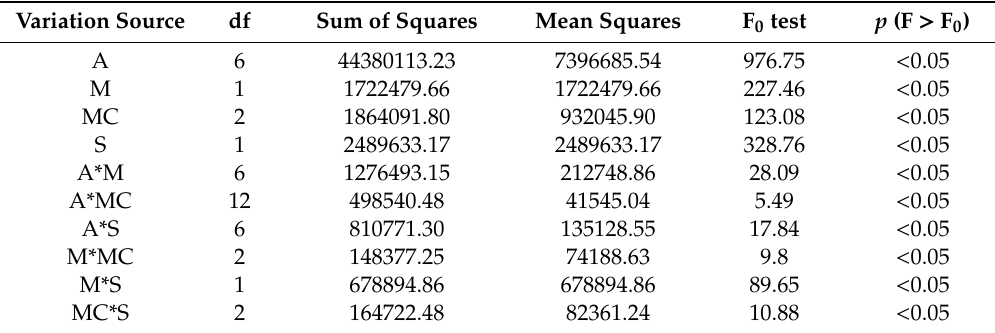
Figure 6. Resistance for the compression of starch foams extrusion with various amounts of PVA and the initial moisture content of raw materials processed with different forming dies at various screw Table 5. Statistical analysis of the effect of variation source and its interactions on resistance for the compression (RC) of starch-based foams.